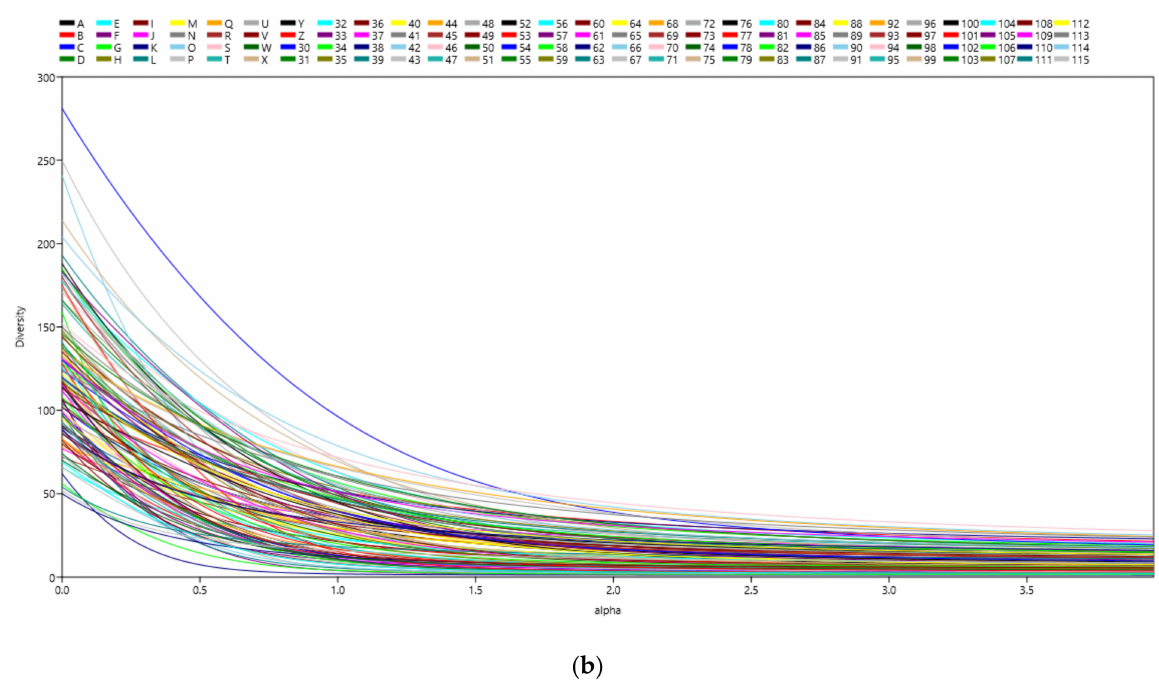
Figure 1. Diversity profiles. ( a ) Rarefaction curves of operational taxonomic units (OTUs) which are clustered at 97% sequence identity across the 113 samples of anisakids. All samples are represented. None fish host or anisakids species seems to be related with the bacterial OTUs diversity structure. ( b ) Diversity ordering by mean of Renyi ´ s index family curves showing differences in OTUs diversity among each anisakid individuals. The Renyi index estimates total richness for a = 0, Shannon-Weiner index for α = 1, the inverse Simpson-Yule index for α = 2 and 1/Berger-Parker index for α = Infinite. Most of the anisakids individuals are non-comparable because their diversity profiles are